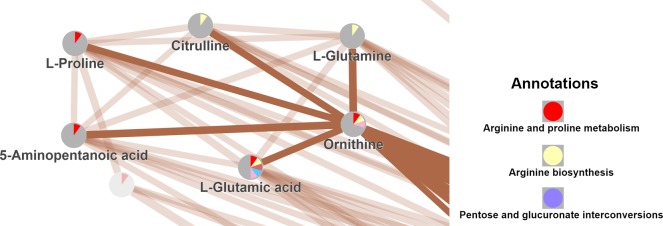
Partial visualization of the entire ‘chemical structure similarity’ network of metabolites in a lung adenocarcinoma study.Chemical similarities between all identified metabolites was calculated from PubChem substructure fingerprints. Network nodes are connected by correlation coefficients using edge thickess for correlations rxy>0.7. Metabox functional class scoring was applied to estimate significantly enriched pathways (p<0.05), yielding arginine/proline metabolism, arginine biosynthesis and pentose/glucuronate interconversions among other pathways. Pathway enrichments are given by color in node pie charts.